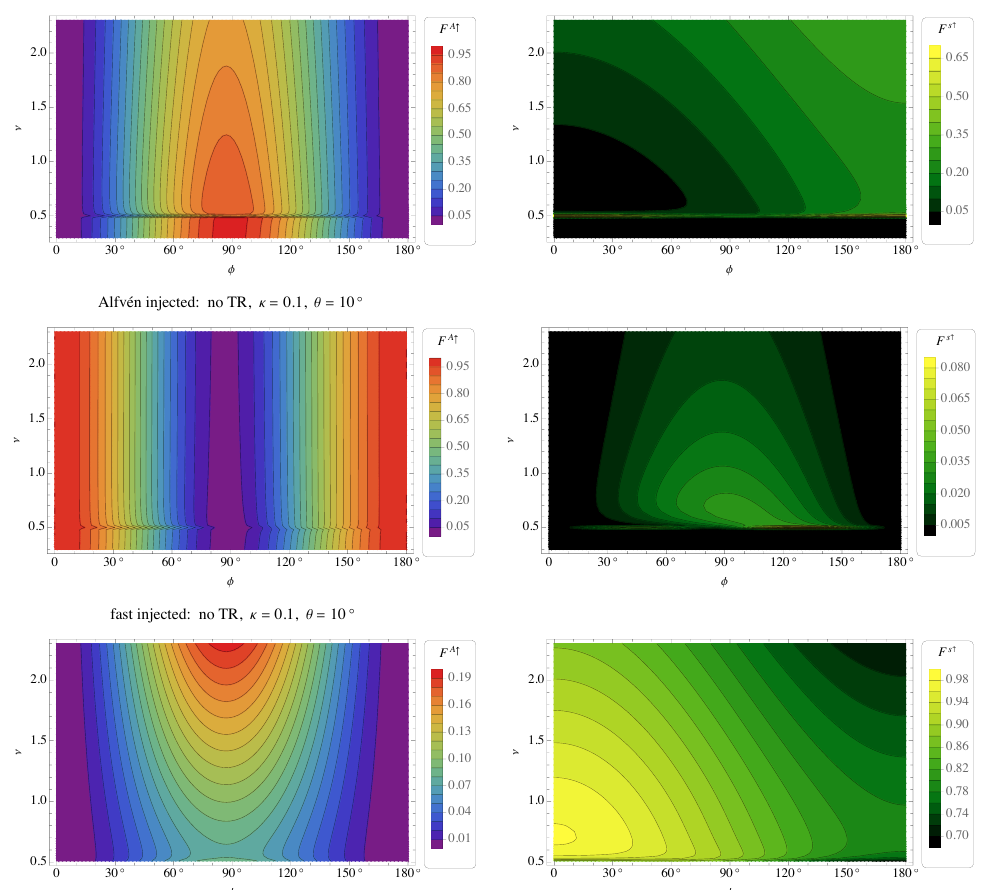
Figure 2. Alfvén ( left column ) and slow ( right column ) fluxes reaching z = + ∞ for injected slow ( top row ), Alfvén ( middle row ) and fast ( bottom row ) waves from z = − ∞ as functions of orientation φ and dimensionless frequency ν in the case κ = 0.1, θ = 10 ◦ in a uniformly isothermal atmosphere (no TR). The injected fast wave does not propagate vertically below the acoustic cutoff frequency 0.5, and so is absent below that value in the bottom